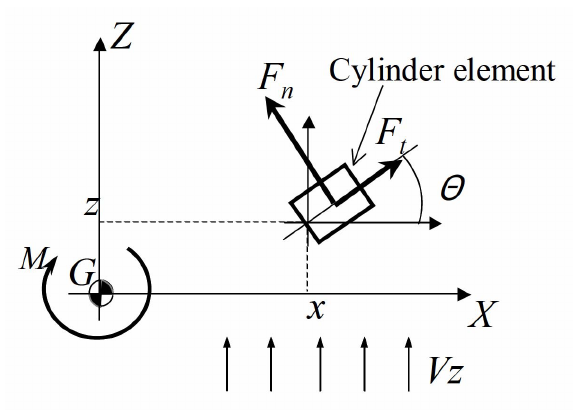
Fig. 13 Analytical model of one cylinder